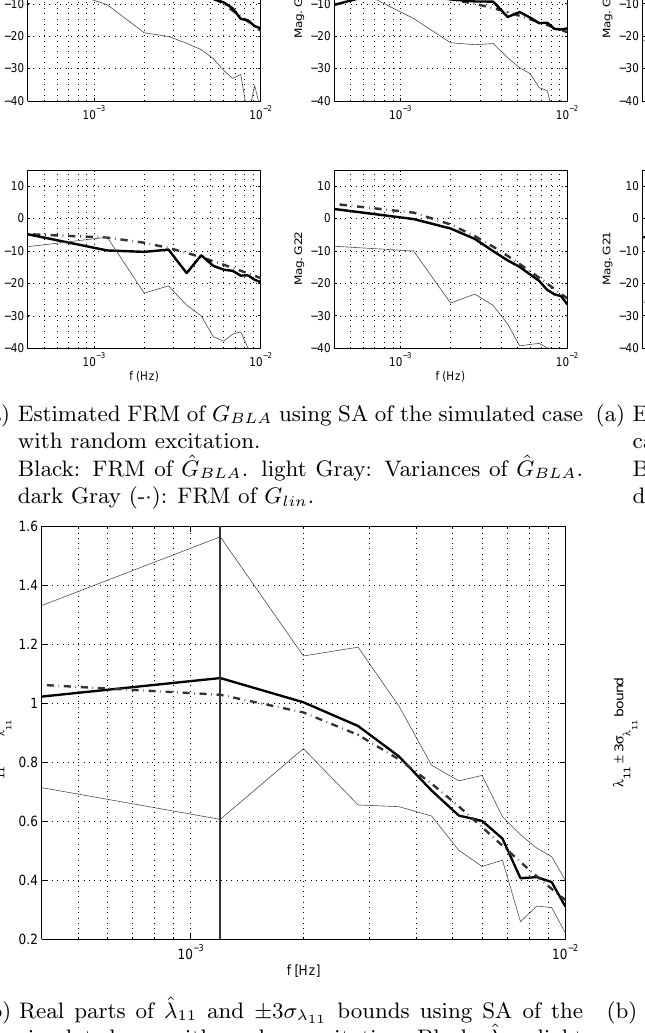
10 −3 10 −2 10 −3 10 −2 (b) Real parts of ˆ λ 11 and ± 3 σ λ bounds using SA of the (b) Real parts of ˆ λ 11 and ± 3 σ λ bounds using LPA of the 11 11 simulated case with random excitation. Black: ˆ λ 11 . light simulated case with random excitation. Black: ˆ λ 11 . light Gray: ˆ λ 11 ± 3 σ λ uncertainty bounds. dark Gray (- · ): Gray: ˆ λ 11 ± 3 σ λ uncertainty bounds. dark Gray (- · ): 11 11 λ 11 calculated based on G lin . Bold vertical line: indi- λ 11 calculated based on G lin . Bold vertical line: indi- cates 0.0012 Hz . cates 0.0012 Hz .